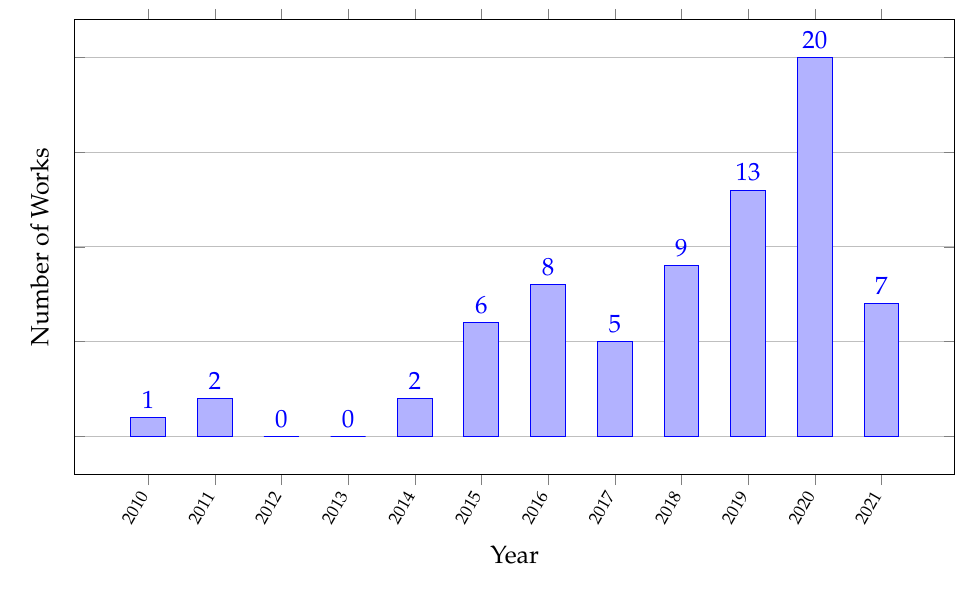
Figure 2. Year of publication.